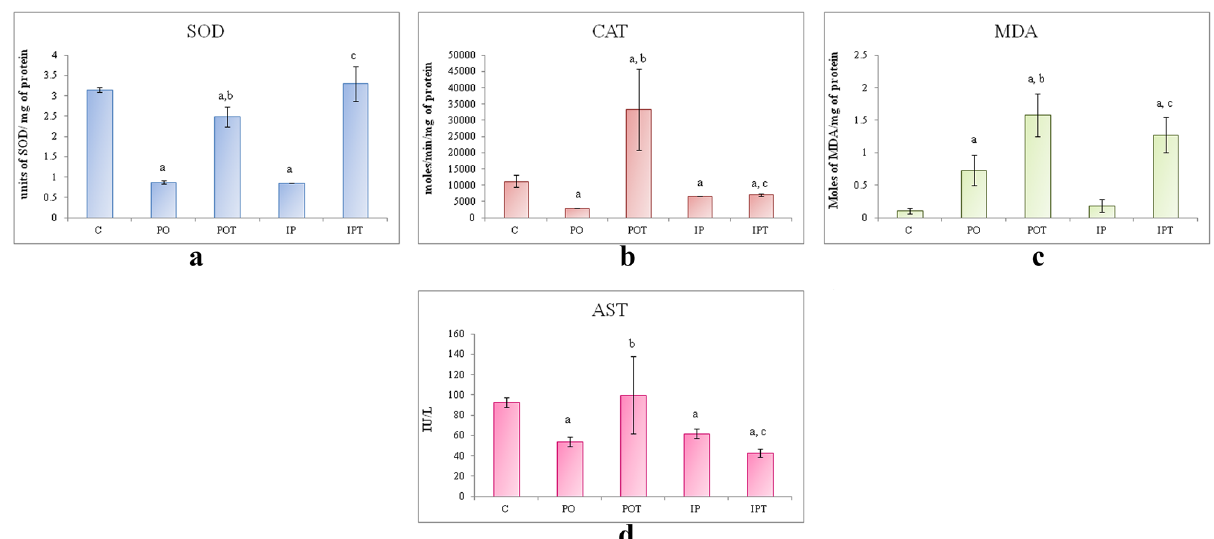
Figure 10. ( a ) Comparison of SOD activity in brain of the control, experimental and treated animals. ( b ) Comparison of CAT activity in brain of the control, experimental and treated animals. ( c ) Comparison of MDA activity in brain of the control, experimental and treated animals. ( d ) Comparison of AST activity in brain of the control, experimental and treated animals. The results of biochemical assays are shown in mean ± SE (‘a’ symbolizes p < 0.005 control vs experimental groups, ‘b’ symbolizes p < 0.005 experimental vs treatment groups (PO vs POT) and ‘c’ symbolizes p < 0.005 IP vs